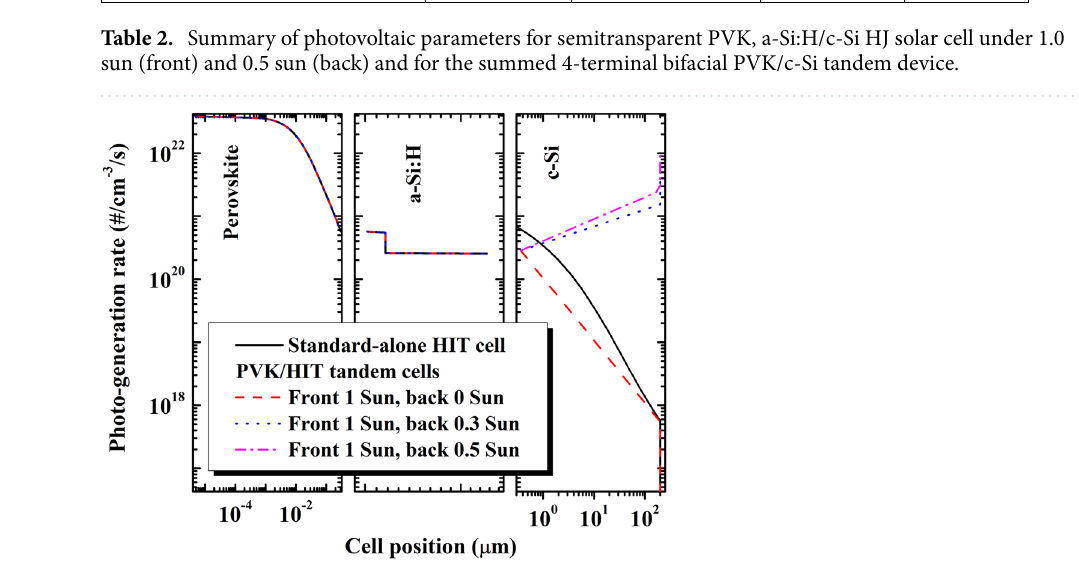
Figure 8. Plots of the photo-generated rate in a bifacial 4-terminal PVK/c-Si HJ tandem solar cell, with variation in the albedo spectrum, as a function of the cell position; here, the red, blue, and pink lines indicate albedo reflection at 0, 0.3, and 0.5 sun, respectively. The photo-generated rate of the standard c-Si HJ solar cell, as a function of the cell position, was also represented for reference (black